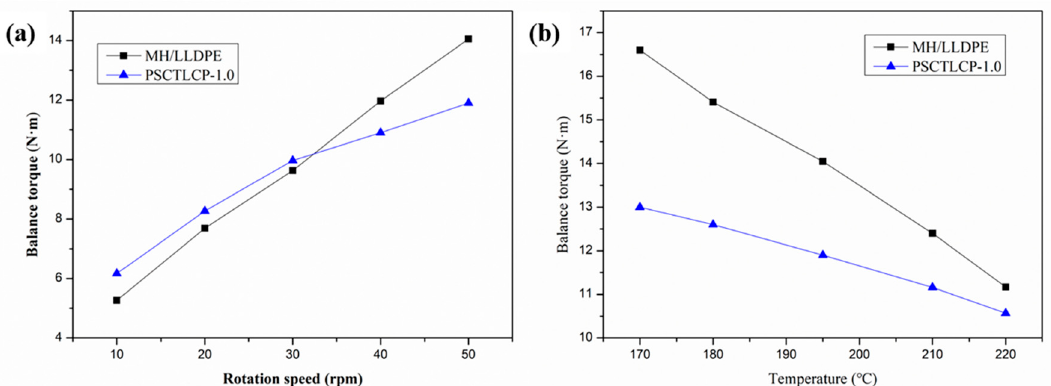
Figure 6. ( a ) Balance torque versus rotation speed and ( b ) balance torque versus processing temperature.